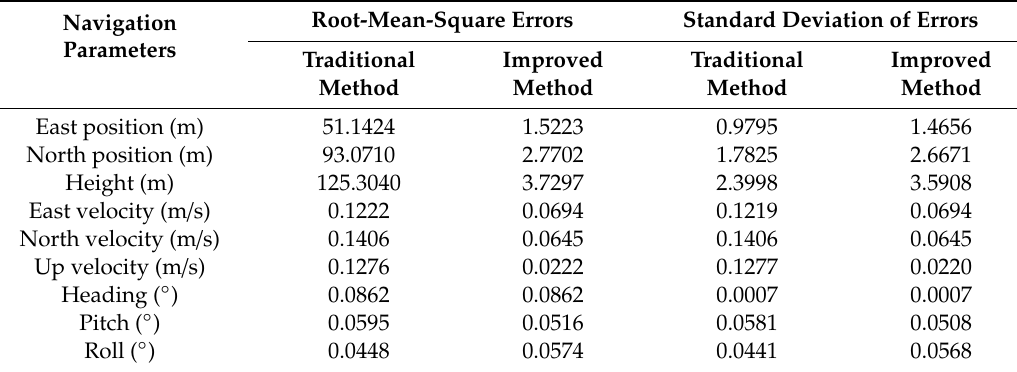
Table 3. Numerical statistics of traditional method and improved method (after 200 s).